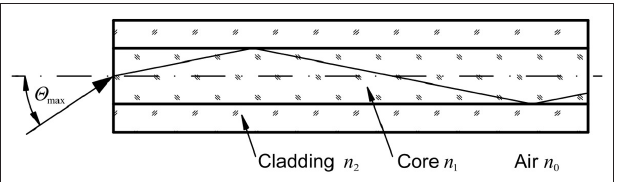
FIGURE 4 | An optical fiber consisting of two materials with different refractive indexes ( n 1 > n 2 ). Light with an angle of incidence that is smaller than the acceptance angle Θ max can enter and is transmitted.